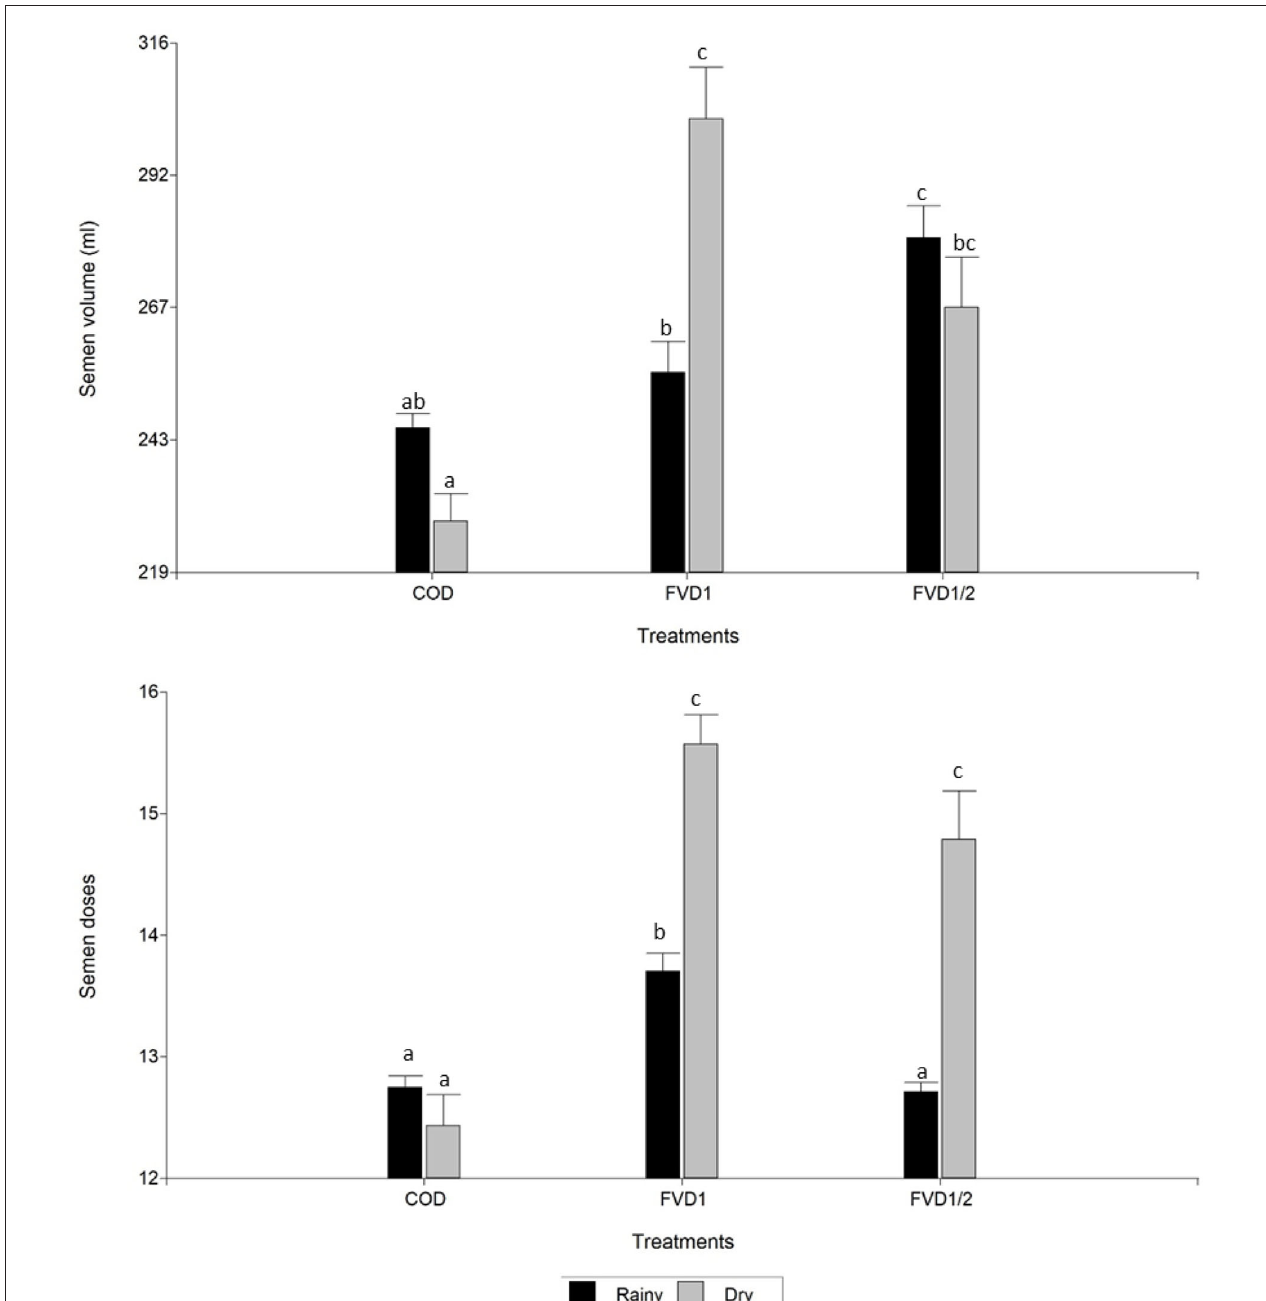
FIGURE 2 | Semen volume and seminal doses produced of boar ejaculates by season according dietary fat-soluble vitamin supplementation. n = 58 ejaculates. Data are expressed as the mean ± standard error of the mean. COD, control group ( n = 11 ejaculates); FVD1, 100% fat-soluble vitamin supplementation group ( n =